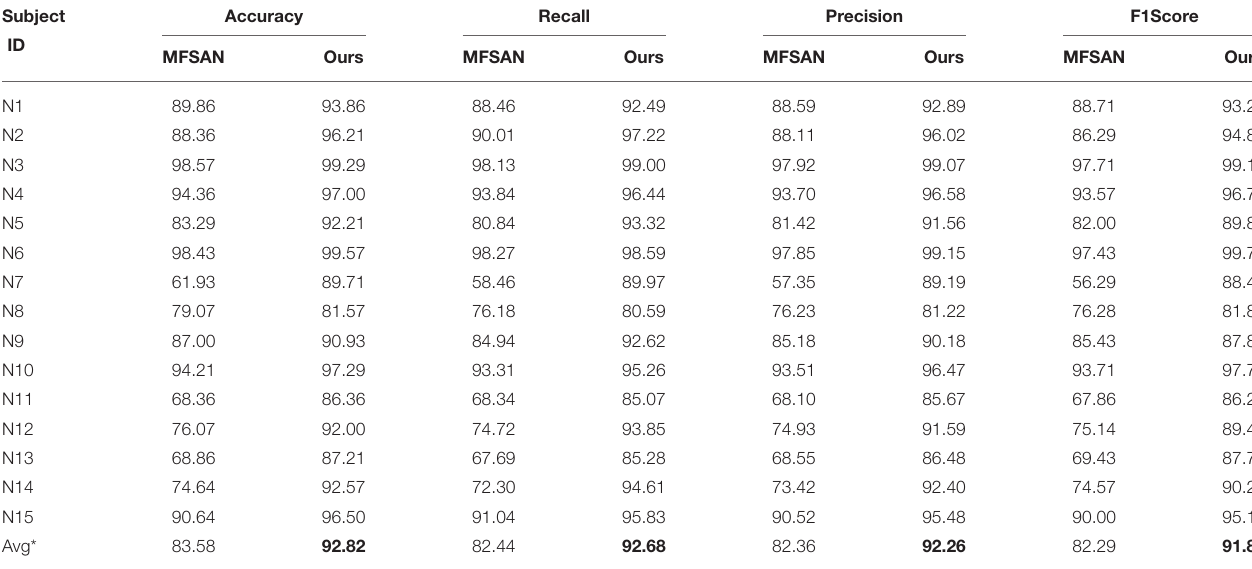
TABLE 3 | The performance of Accuracy, Precision, F1Score, and Recall for multi-source models of each subject